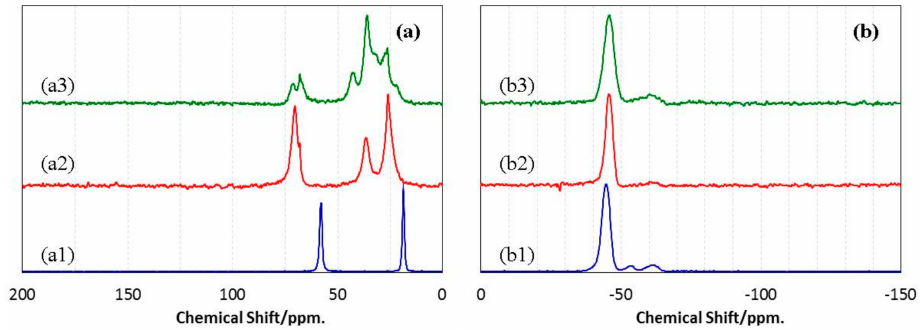
Figure 3. ATR-IR spectra of (a) EtOSZ; (b) CyOSZ and (c) DHNpOSZ.